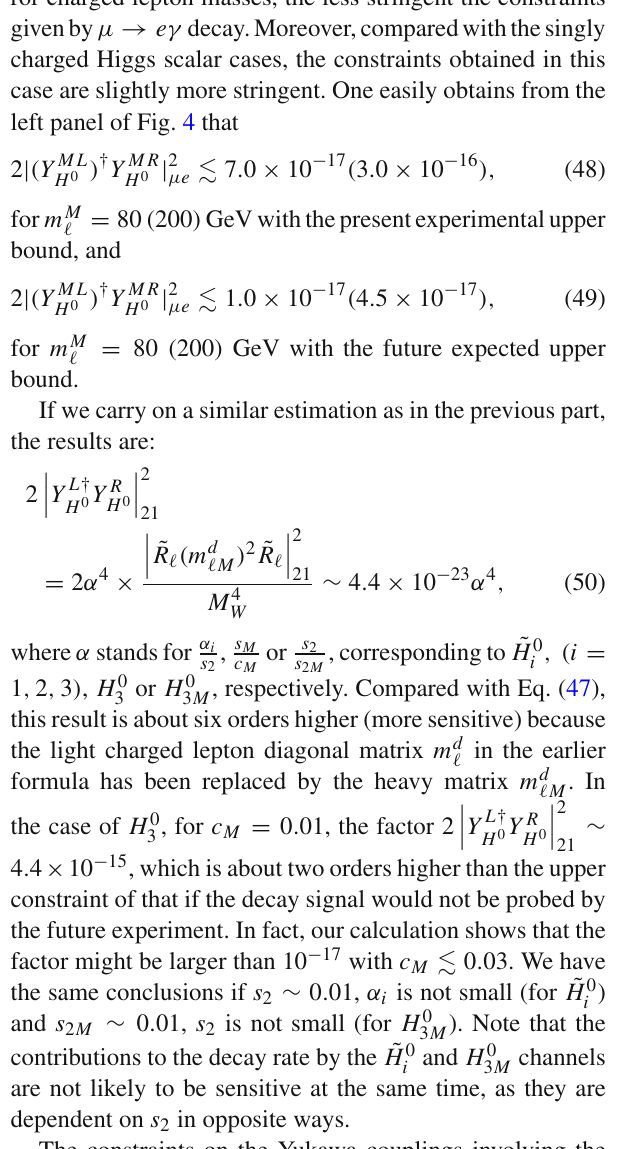
for m M (cid:4) = 80 ( 200 )